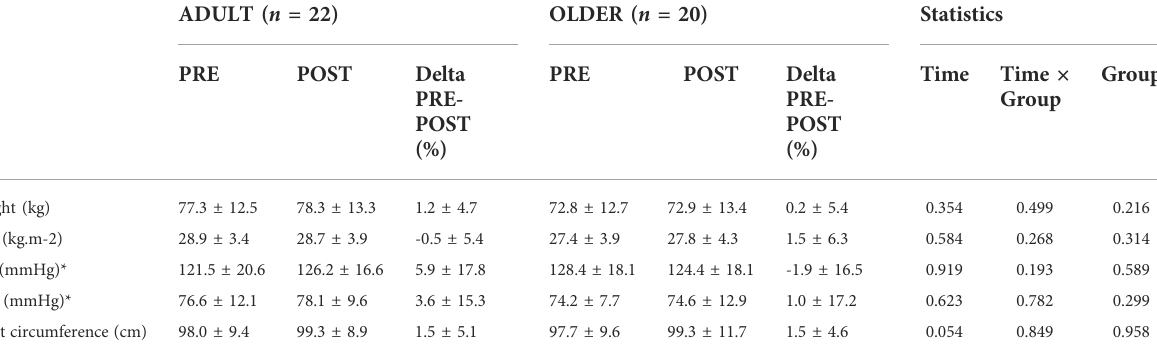
TABLE 2 Blood pressure and body composition parameters before and after hybrid exercise-based cardiac rehabilitation